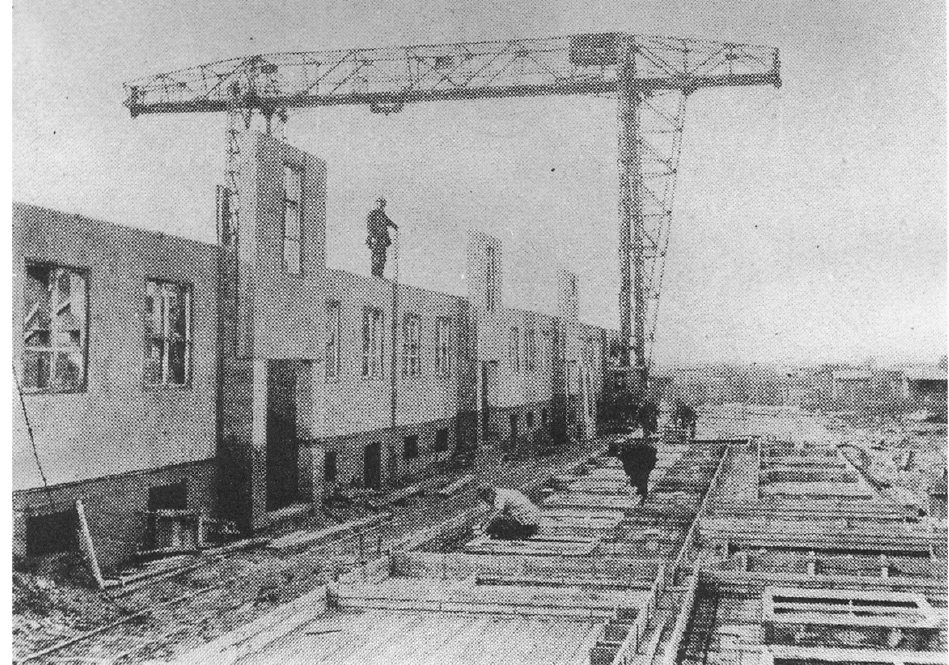
Figure 2. Martin Wagner: Experimental Siedlung in Sewanstraße/Splanemannstraße in Berlin-Friedrichsfelde (1924–1925)—Contruction with the Occident system using a gantry crane (Photo of unknown origin).